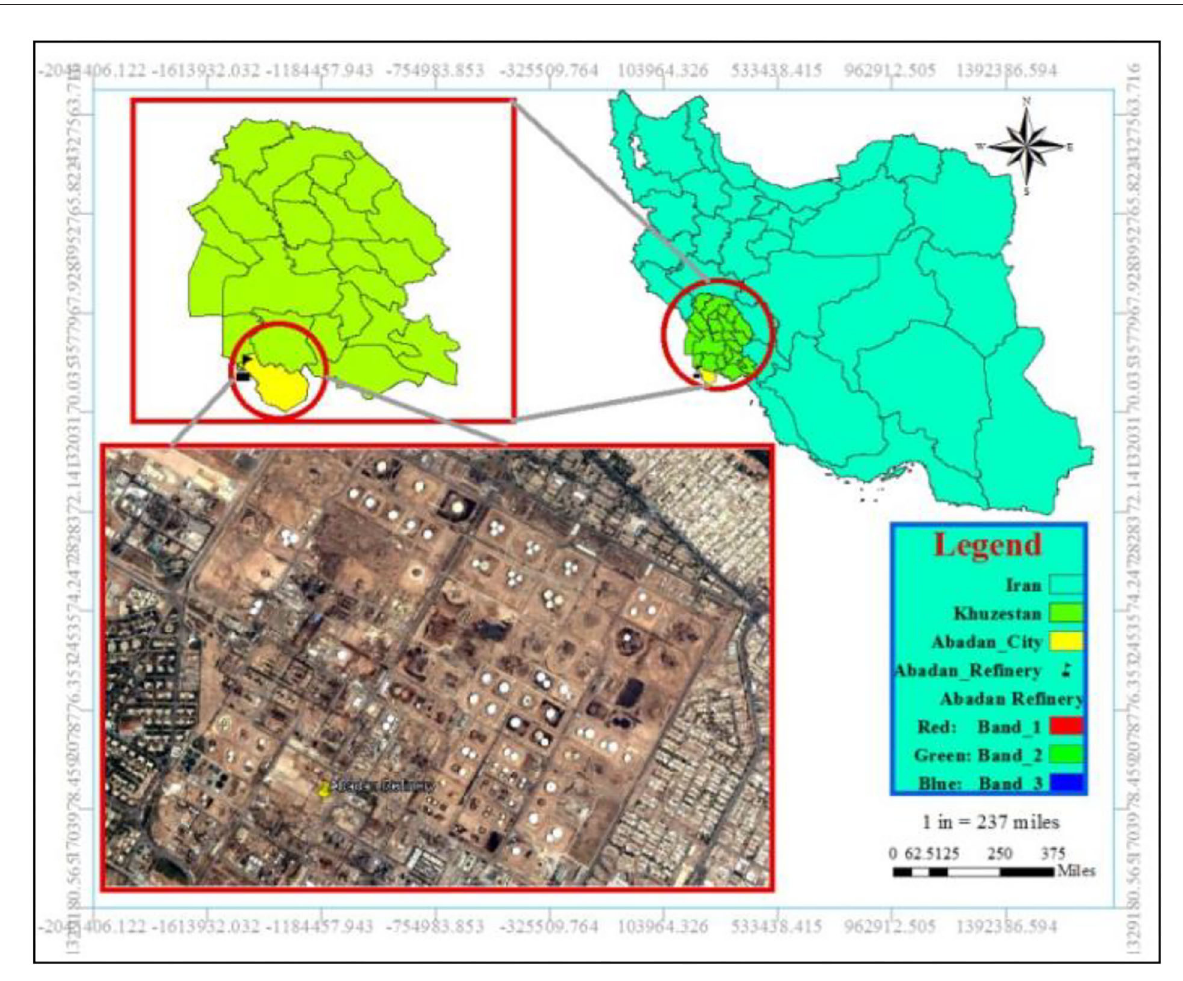
FIGURE1 The location of the Abadan oil